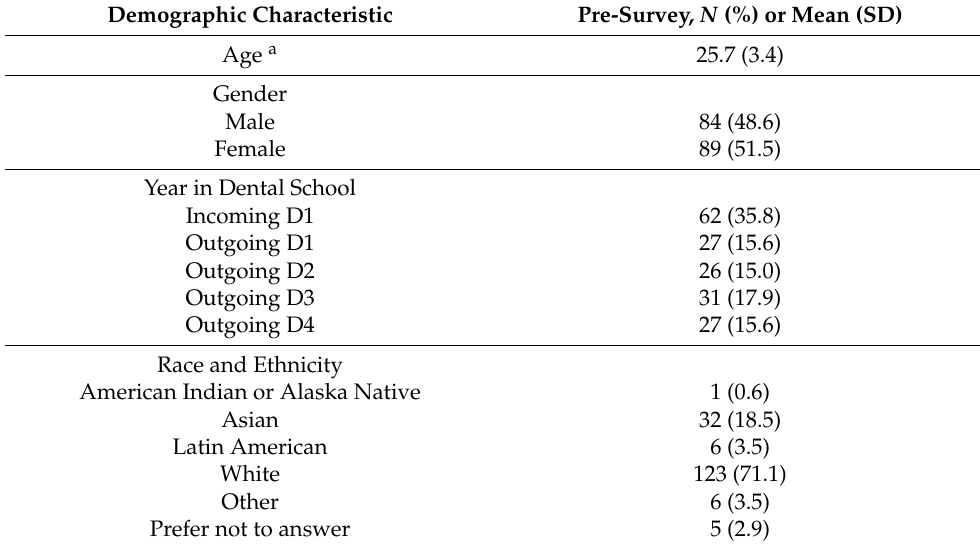
Table 1. Demographic Characteristics ( N = 173).